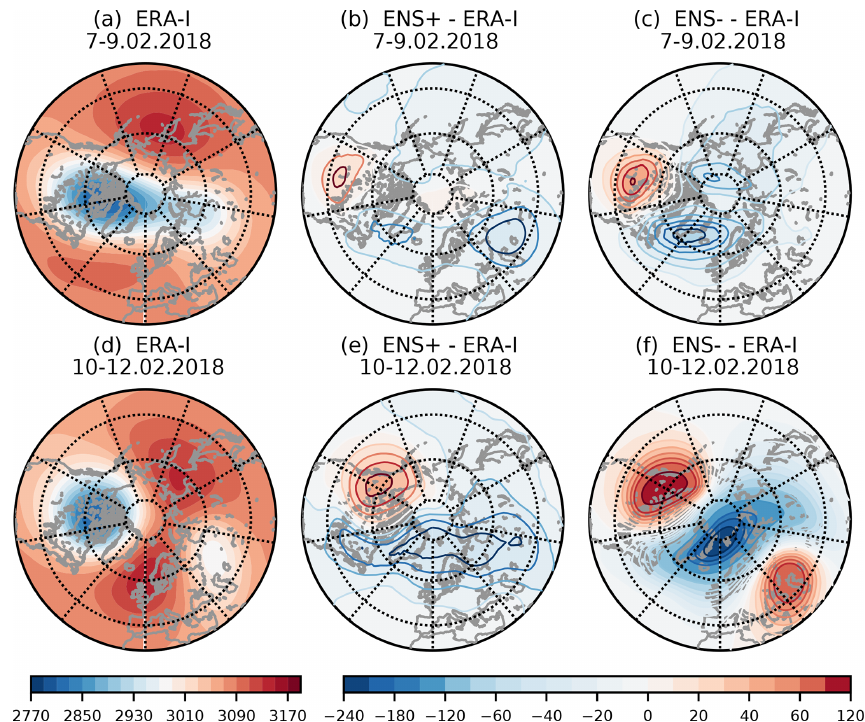
Figure 3. Geopotential height at 10hPa (dam) for two successive 3d means starting from 7 February (a, d) . Difference in geopotential height at 10hPa (dam) between ERA-I and ENS + members (b, e) or ENS − members (c, f) .